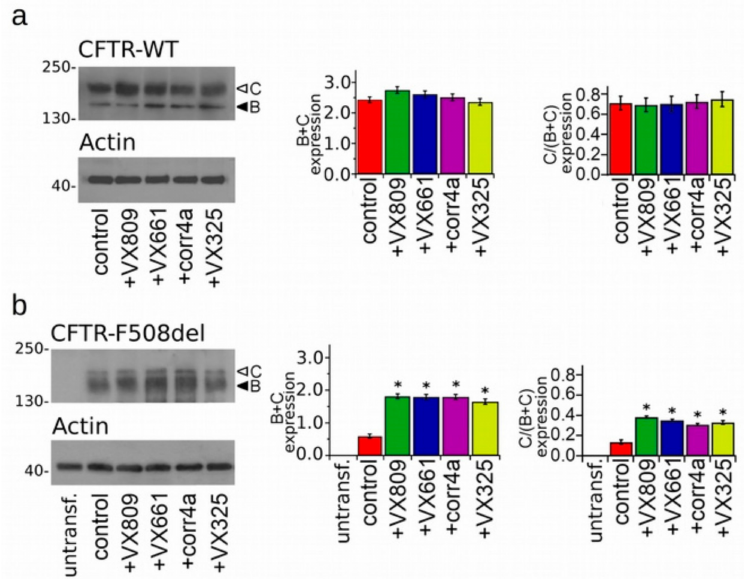
Figure 1. Detection of full-length cystic fibrosis transmembrane conductance regulator (CFTR) proteins. ( a ) Western blot showing the wild type (WT)-CFTR in lysates of transiently transfected human embryonic kidney 293 (HEK-t) cells treated with DMSO (control), lumacaftor (VX809), tezacaftor (VX661), corr4a, and VX325. ( b ) Expression of the phenylalanine at position 508 (F508del)-CFTR in untransfected (untransf.) and in transiently transfected HEK-t whole cell lysates treated with DMSO (control),